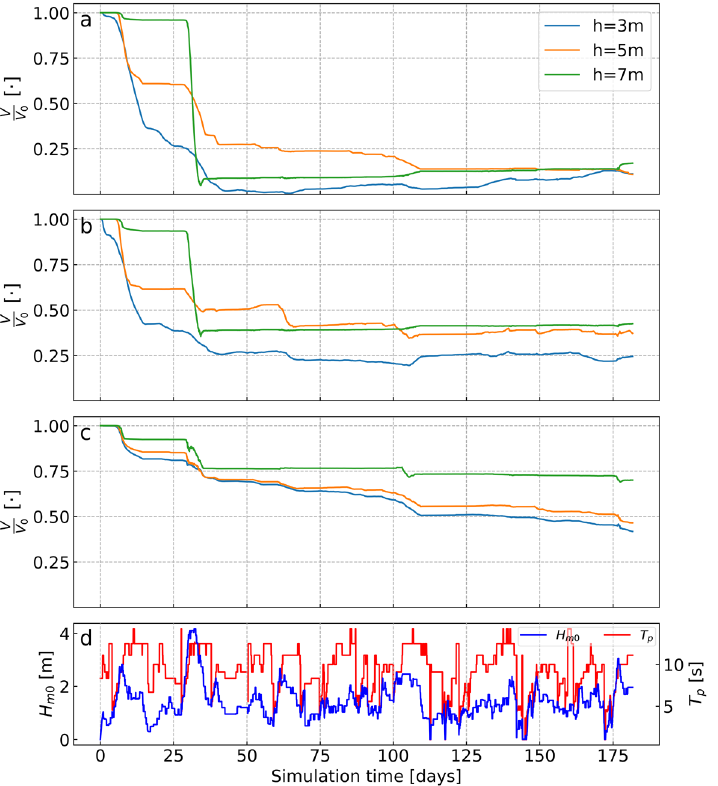
Figure 14. Longevity of nearshore nourishments at Vilano Beach site, in terms of percent placed volume remaining in original footprint through time where the blue, orange, and green colors represent the 3 m, 5 m, and 7 m placement depths, respectively. ( a ) Linear berm; ( b ) undulated berm; ( c ) discrete mounds; ( d ) time series of offshore zero-moment wave height and peak period.